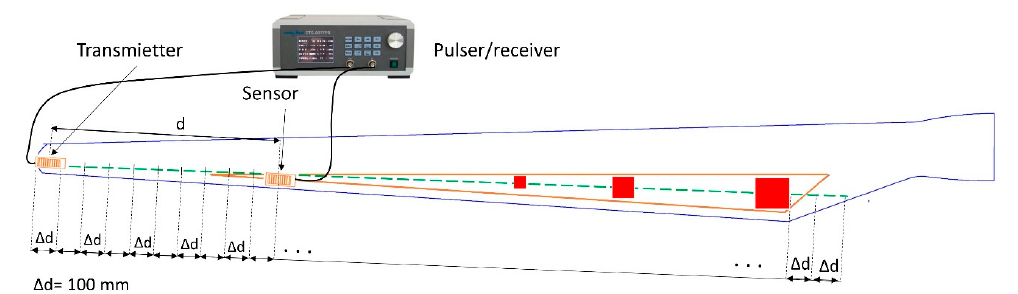
Figure 3. Location of the transducers along the WTB.